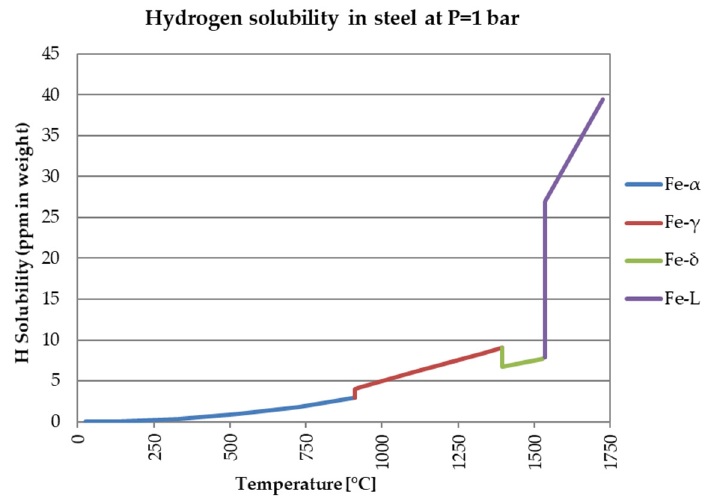
Figure 2. Solubility of H in iron at P-1 bar (made from [15]).